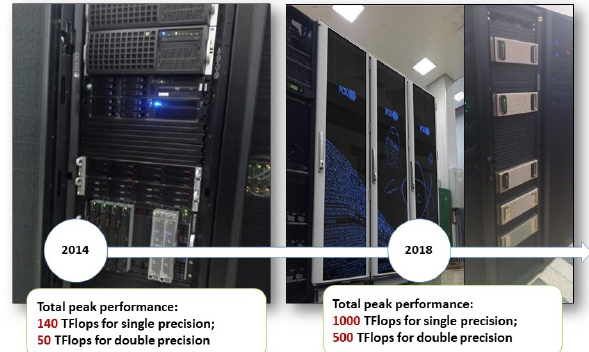
Fig. 3 . From HybriLIT cluster to a HybriLIT platform, the performance increased by 10 times.